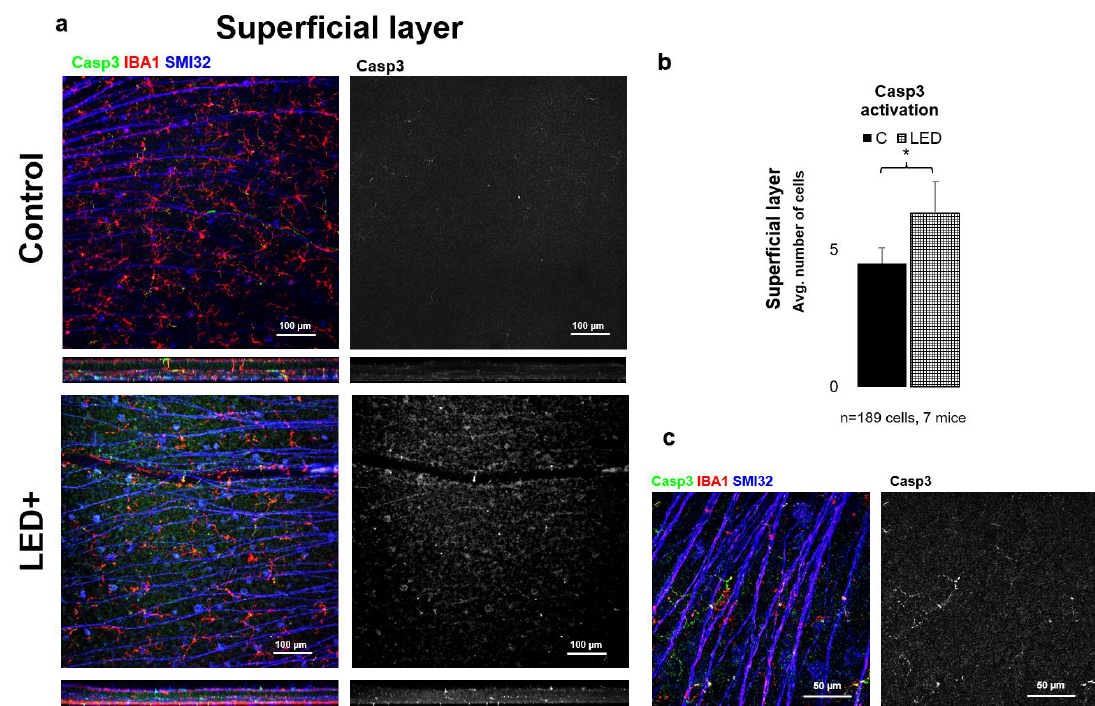
Figure 4. Casp3 activation in the superficial layer. Panel ( a ) shows the ganglion cell layer of control and LED retinas labeled SMI32 (GC marker), Iba1 (MG marker), and Casp3 (Casp3+ cells) scanned with a 20 × objective in a confocal microscope. The colors shown are the same as the colors above the images. In the second column, only Casp3-labeled cells are shown in white. In panel ( b ) the histogram shows the number of Casp3-activated cells in the SL (* p = 0.05). Panel ( c ) shows high-magnification confocal microscopic images scanned with 63 × objective of Casp3+ areas in MG.